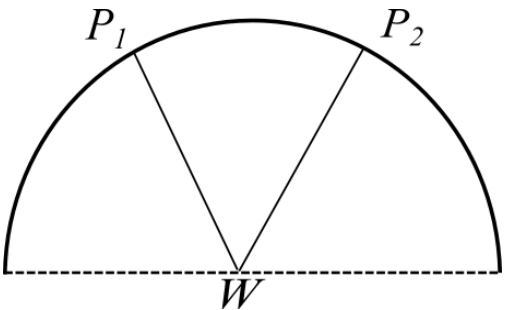
Figure 5 . The contact Witten